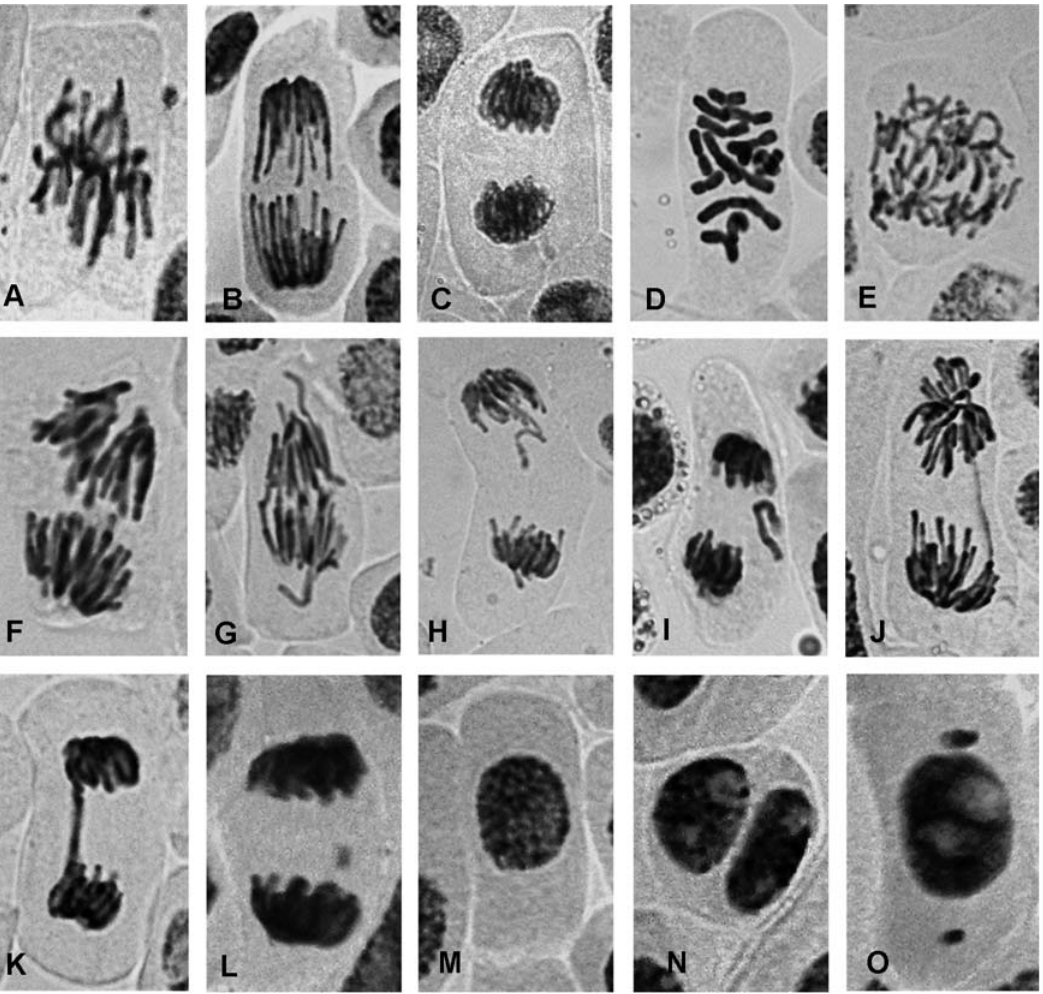
Figure1 -AberrationsinducedbyBr-oxphin Alliumcepa roottips:A-normalmetaphase,B-normalanaphase,C-normaltelophase,D,C-mitosis,E,F - Spindle abnormalities in anaphase, G - vagrant chromosome in anaphase, H, I - vagrant chromosome in anaphase-telophase, J - anaphase bridge, K - anaphase-telophase bridge, L - anaphase-telophase with fragment, M - normal interphase cell, N - binucleated cell, O - micronuclei in interphase